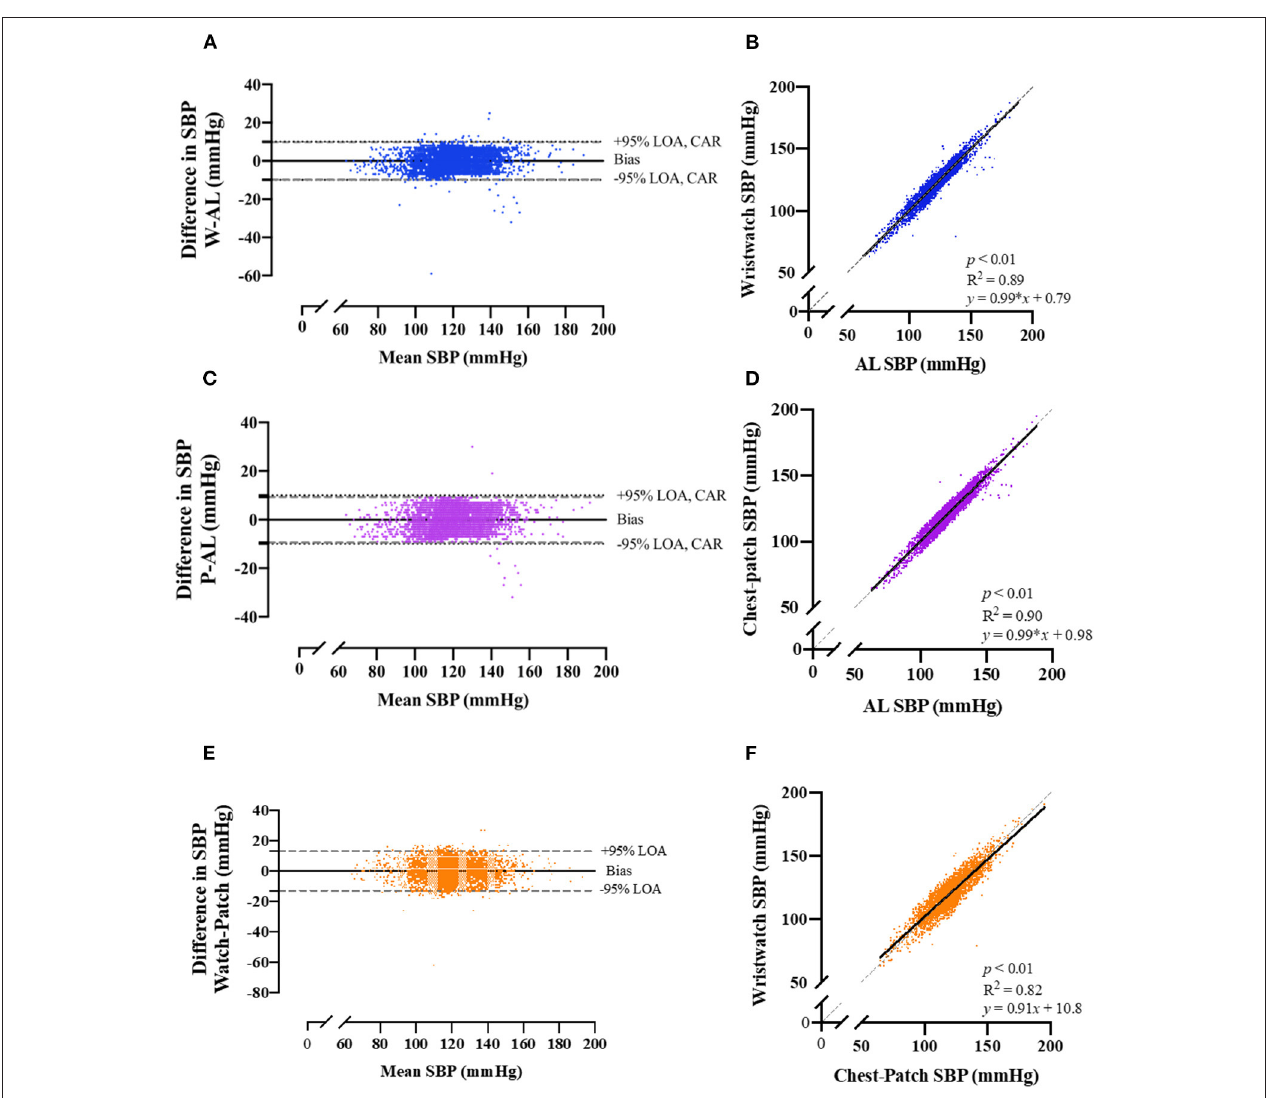
FIGURE 2 | Bland-Altman plots of the relationship and limits of agreement between the photoplethysmography-based devices’ non-invasive systolic blood pressure measurements and the arterial line’s invasive measurements. Bland-Altman plots (left panels) and Pearson’s correlations (right panels) are shown for wristwatch and arterial line (A,B) , chest-patch and arterial line (C,D) , and wristwatch and chest-patch (E,F) . In the right panels, the solid line is the best fit linear regression and the dash line is the line of identity. In the left panels, the solid horizontal line represents the mean difference between the two measurements (bias), the dash horizontal lines represent the 95% limits of agreement (LOA), and the dotted lines represent the clinically accepted range (CAR). W, wristwatch configuration; CP, chest patch configuration; SBP, systolic blood pressure; AL, arterial